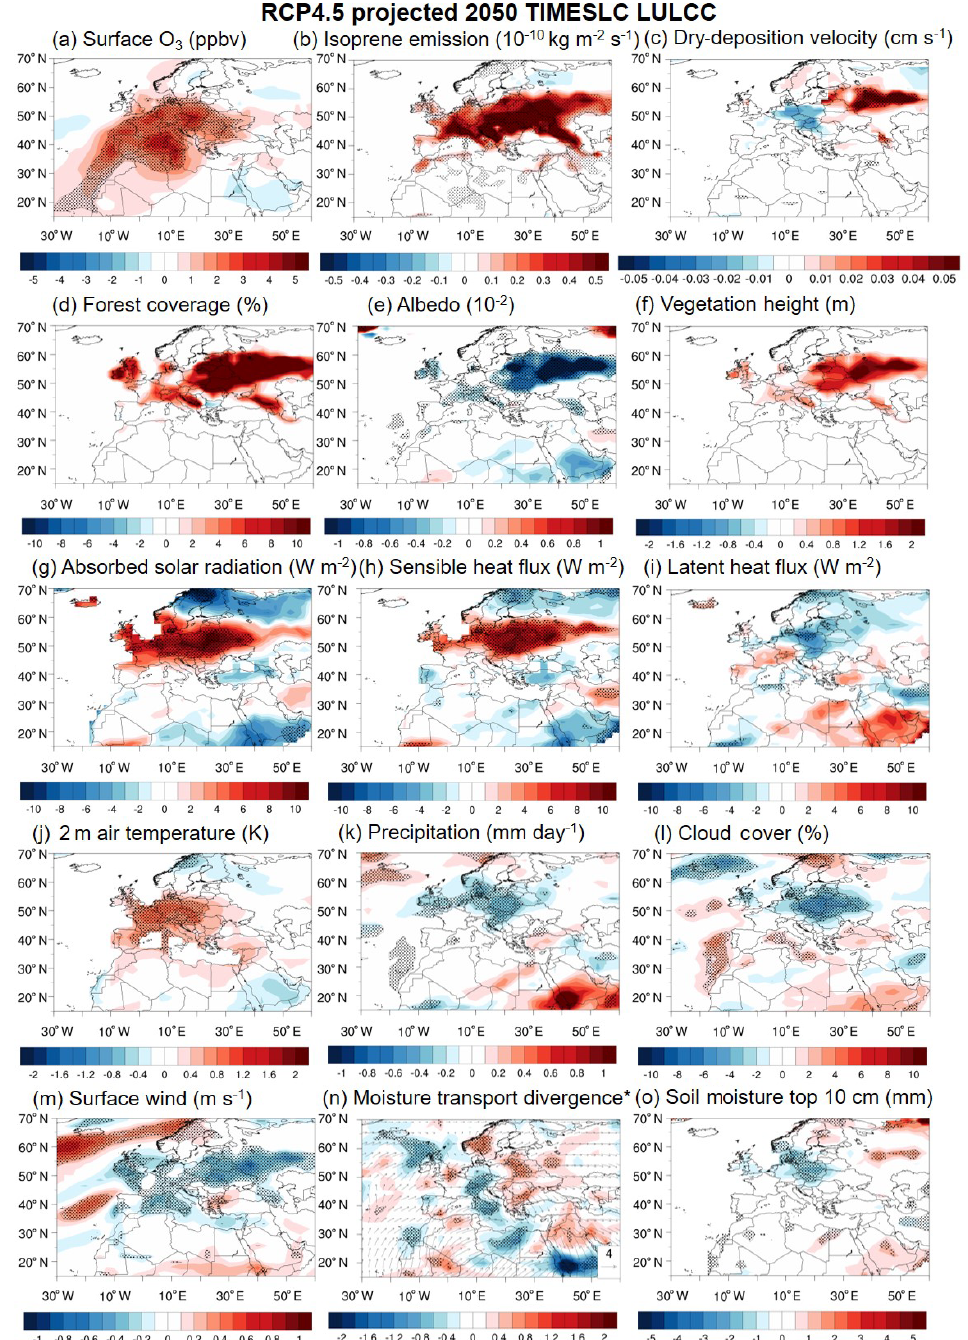
Figure 6. Similar to Fig. 5 but for Europe under